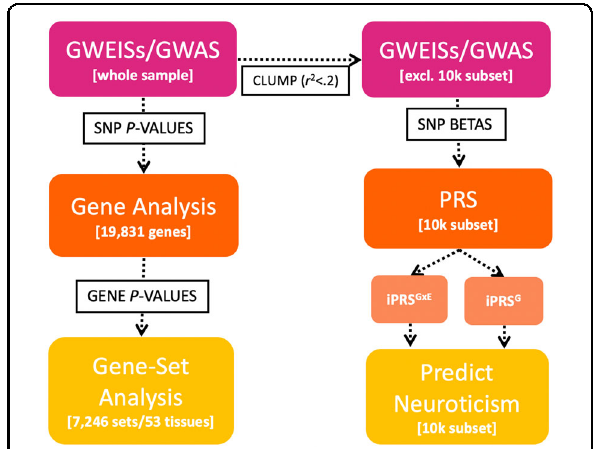
Fig. 1 Overview of the analysis work fl ow. We fi rst obtained SNP- environment interaction effect estimates for the 25 environments (GWEISs), as well as SNP main effects (GWAS). Results from these analyses were used to perform gene and gene-set analyses. The effect of SNPs, genes, and gene-sets that reached standard genome-wide signi fi cance (i.e., not corrected for the 25 environments) in the interaction-based analyses were compared with their corresponding main effects. Interaction-based polygenic risk scores (iPRSs) were constructed in an independent subset of the sample to predict neuroticism: this was done by modelling the interactions between each environment and a polygenic risk score constructed based on either the SNP-environment interaction effect from GWEIS (iPRS GxE ), as well as the SNP main effect from GWAS (iPRS G ) as a